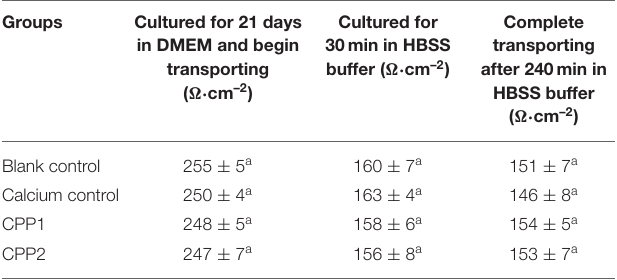
TABLE 2 | Transepithelial electric resistance (TEER) values of the cell monolayers in between the samples and control during the whole experimentation. Groups